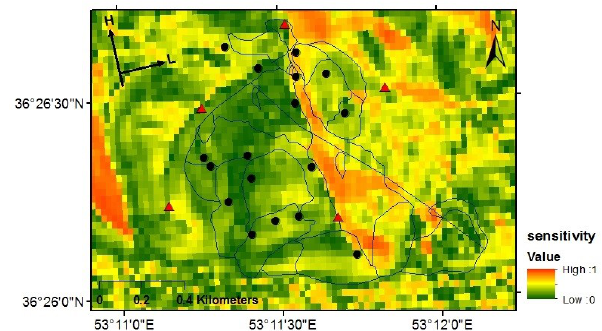
Figure 5: Sensitivity map of the LOS observations from the ALOS satellite in ascending mode with incidence angle of 35° and heading of -13° to the slope movement in Shabkola landslide. Polygons show the landslide body. GPS reference and measuring stations are depicted with red triangles and black circles, respectively. H and L vectors show the heading and LOS direction of the satellite, respectively.